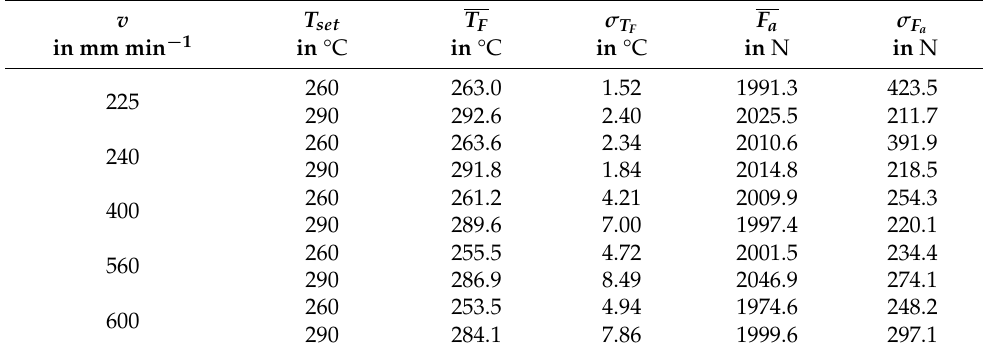
Table 5. Average temperature T F in °C and average axial force F a of the transfer tests with the material combination PA6-GF30 with EN AW-6082